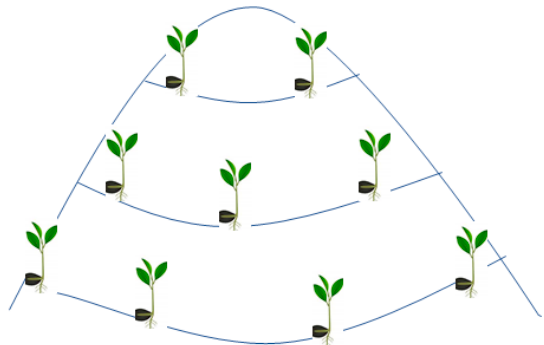
Figure 6. Contour pattern of planting. Number of hedges × Unit area Plant population = S (a + b)